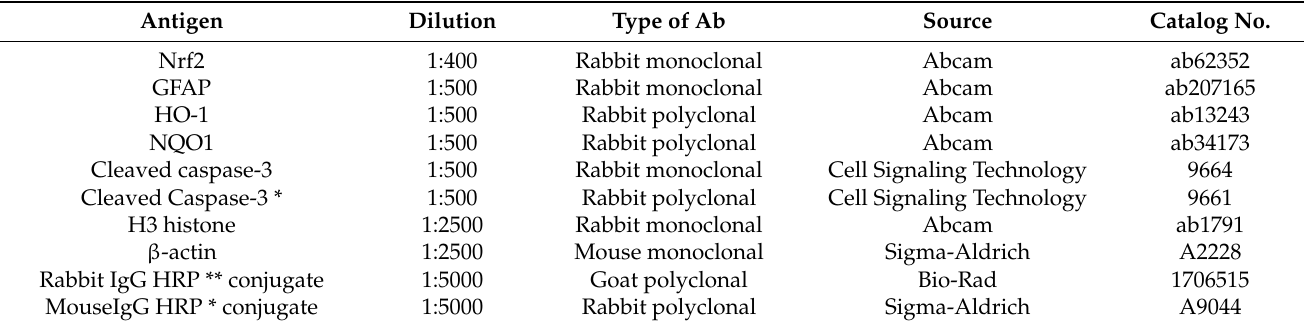
Table 2. Antibodies used for the Western